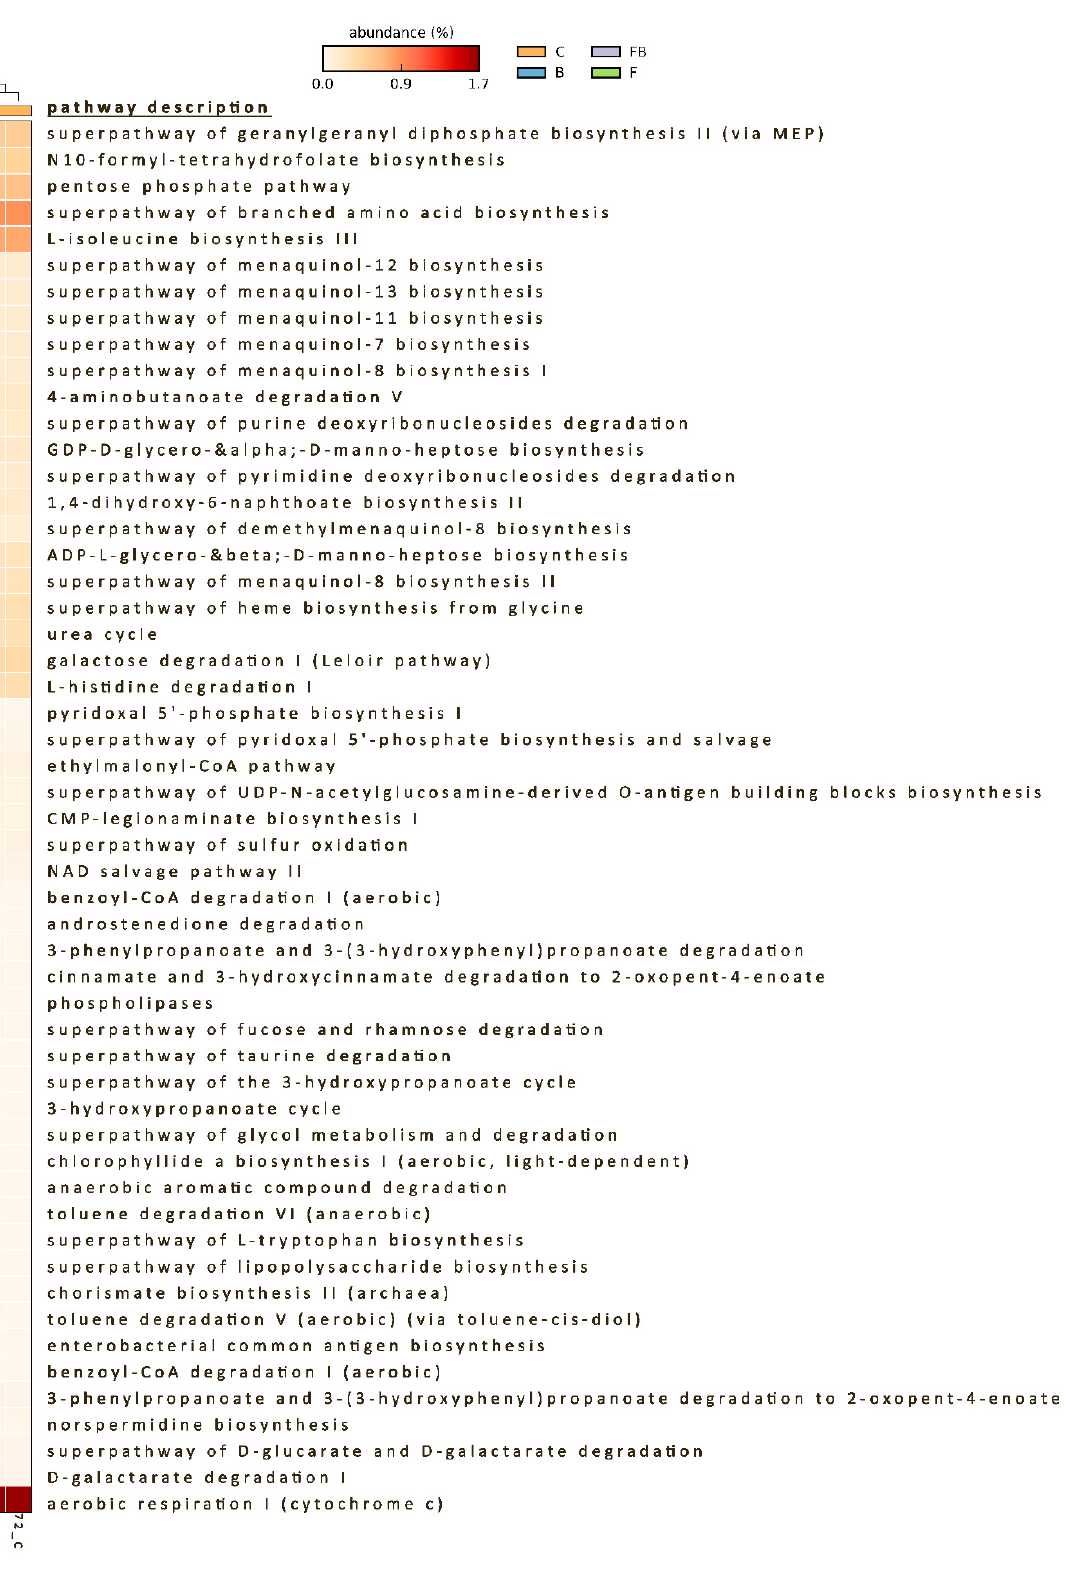
Figure 7. Heatmap of the predicted functional profile for the control (C), biosolid (B), Forl inoculation (F), and combination of Forl inoculation and biosolid application (FB) analyzed using STAMP software. The key shows the % relative abundances for p -value ≤ 0 .05 and effect size > 0.85 (n = 3).